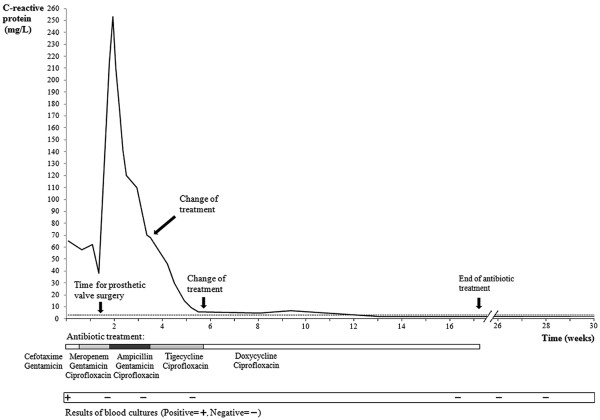
Comparison between C-reactive protein (CRP) levels and treatments given over time. The first antibiotic regime was cefotaxime and gentamicin administered for three days. After the prosthetic valve surgery, the patient received antibiotics for four months. Twelve weeks after surgery, CRP was found to be repeatedly at a normal level. Only the initially drawn blood cultures showed growth of Mycobacterium goodii. The broken line indicates CRP ≤ 3.0 g/L.